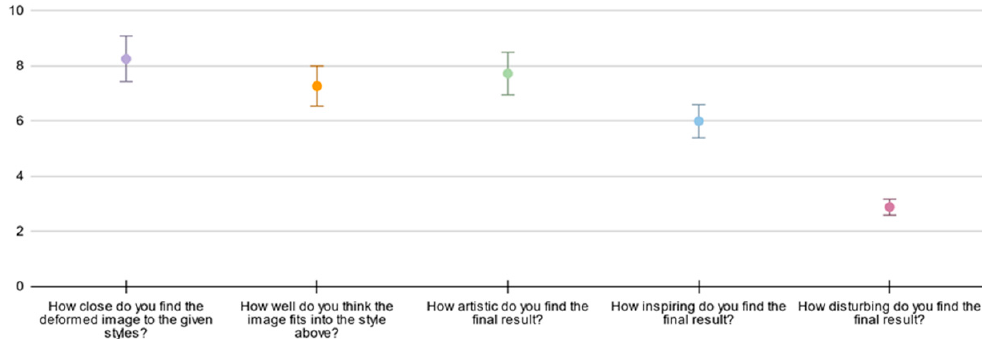
Figure 3. Survey results.